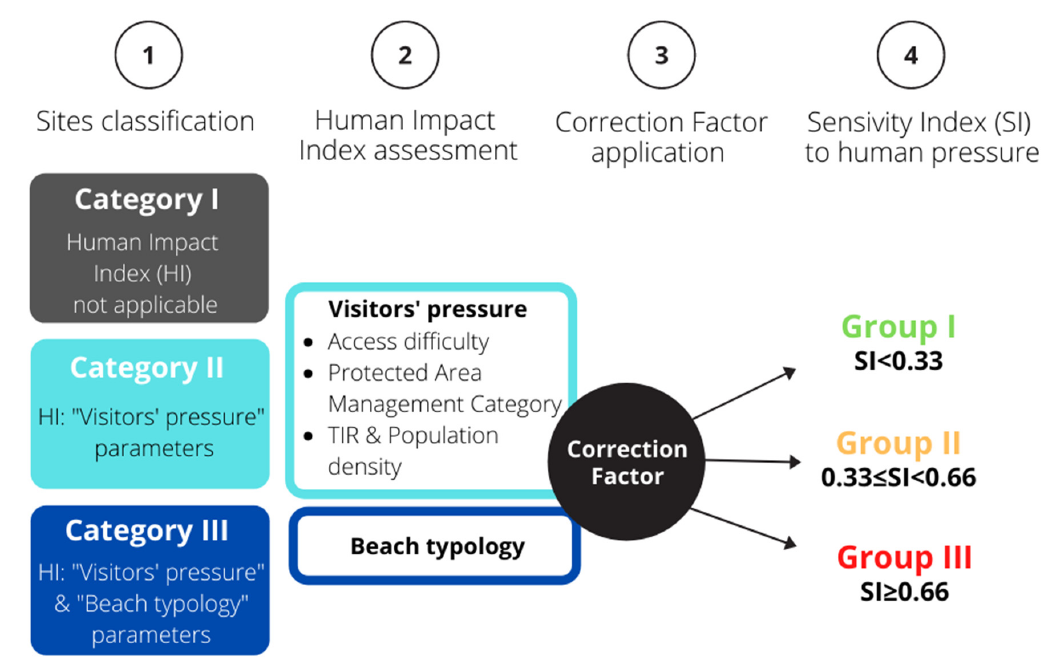
Figure 7. Steps for assessing scenic sensibility to human pressure.